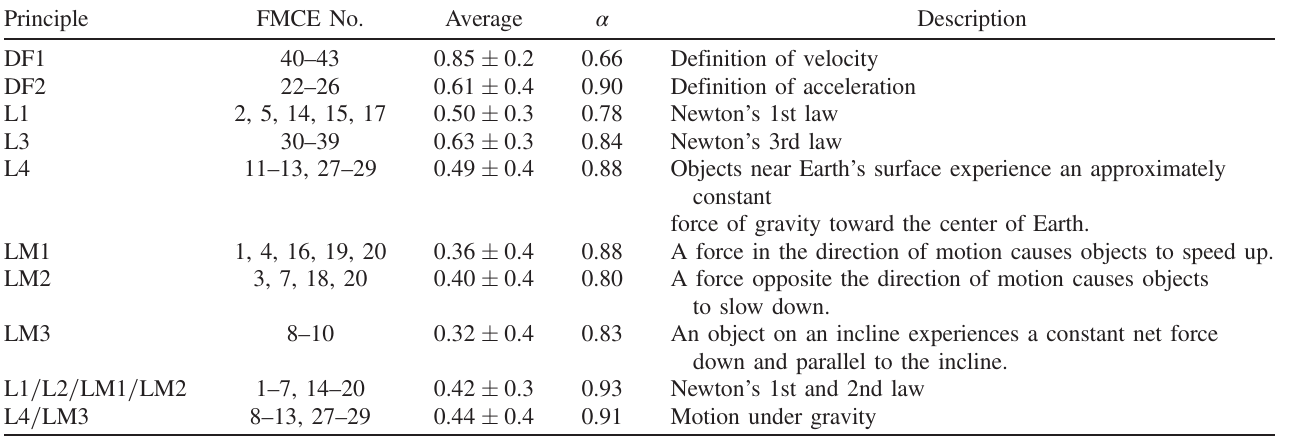
TABLE VIII. FMCE subscales. Average score presented as mean (cid:3) standard deviation; Cronbach ’ s α provides a measure of internal